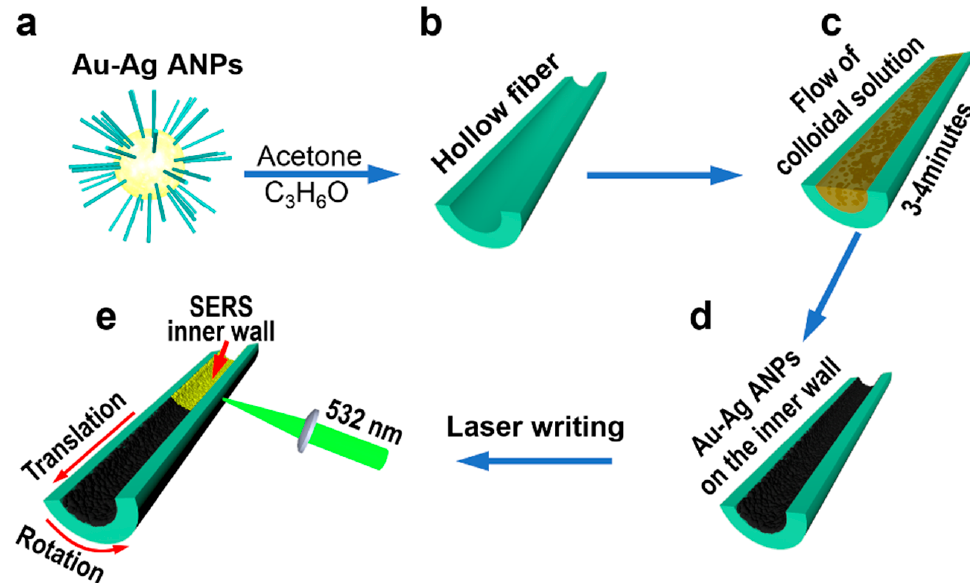
Figure 1. Preparation of SERS nanostructures on the inner wall of a hollow fiber. ( a ) Chemically synthesized gold and silver alloy nanoparticles (Au–Ag ANPs) with ligands. ( b ) Quartz hollow fiber. ( c ) Filling the hollow fiber with the colloidal solution of Au–Ag ANPs in acetone. ( d ) Coating of the colloidal Au–Ag ANPs onto the inner wall of a hollow fiber by flowing the colloidal solution for 3–4 min. ( e ) Direct laser writing of the SERS hollow fiber.